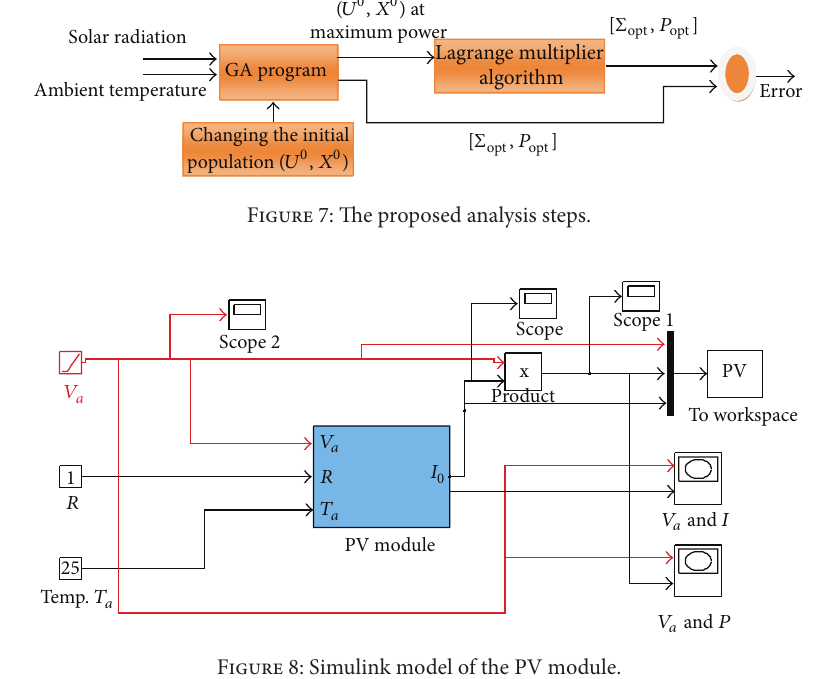
Figure 8: Simulink model of the PV module.